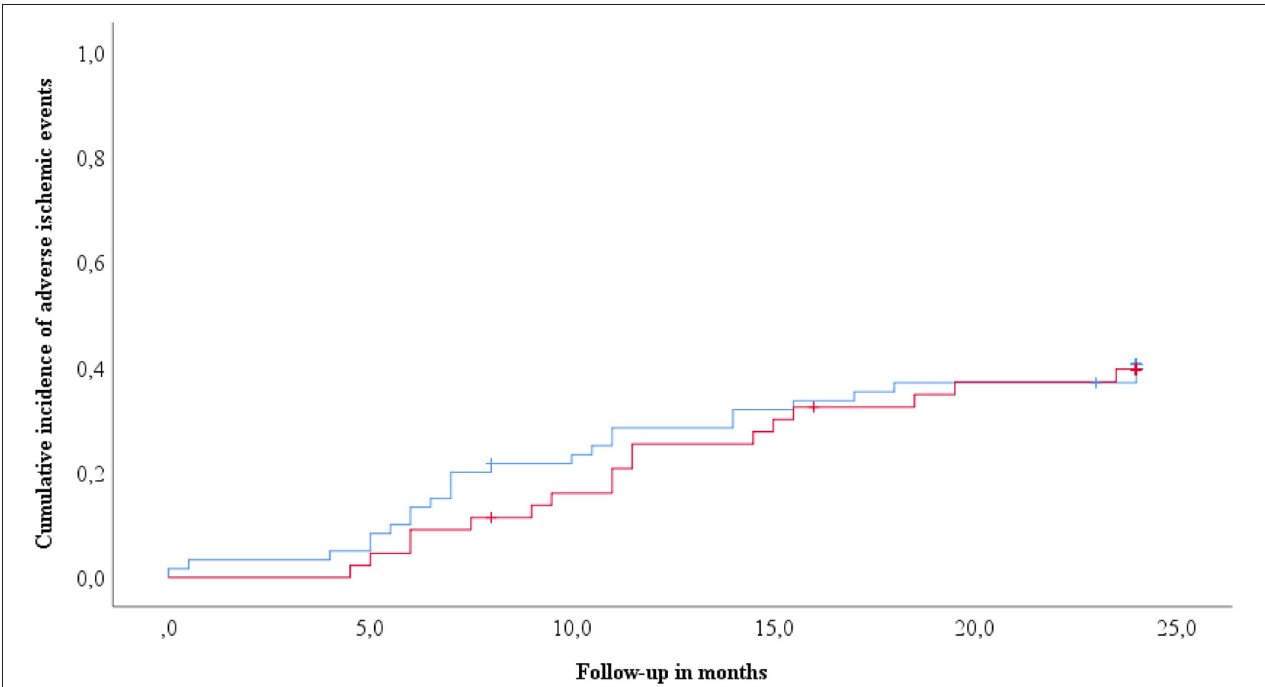
FIGURE 3 | Cumulative incidence of adverse ischemic events according to circulating sST2. Kaplan-Meyer analyses for the cumulative incidence of adverse ischemic events (primary endpoint) following infrainguinal angioplasty and stenting stratified according to circulating sST2 levels. sST2 above the median is indicated by the red line. The blue line indicates sST2 below